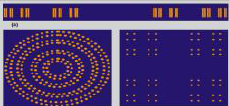
Figure 3 : Calculated array factor of a Cantor linear